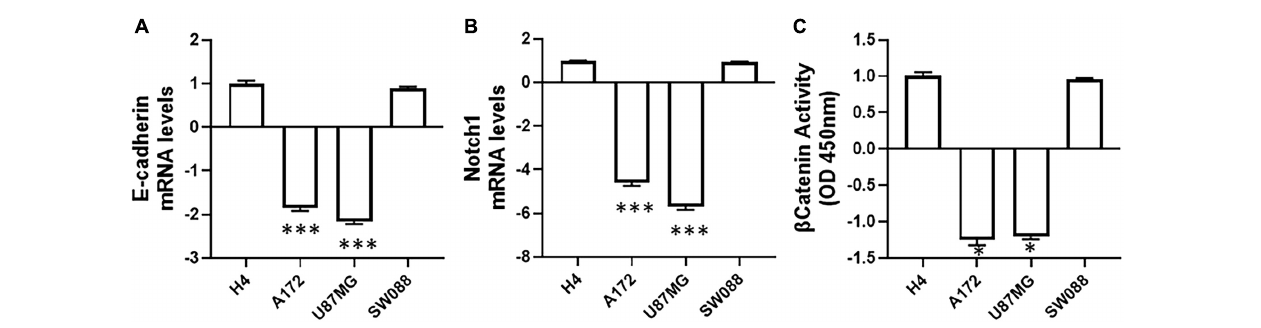
FIGURE 2 | Endogenous EMT and other related markers in glioma cell lines. Levels of (A) E-cadherin, the EMT biomarker and (B) Notch1 were evaluated in four glioma cell lines by qRT-PCR. GAPDH was evaluated as internal control. (C) The activity of β -catenin was evaluated using a commercial kit as described in Methods. ∗ p < 0.05 and ∗∗∗ p < 0.01.